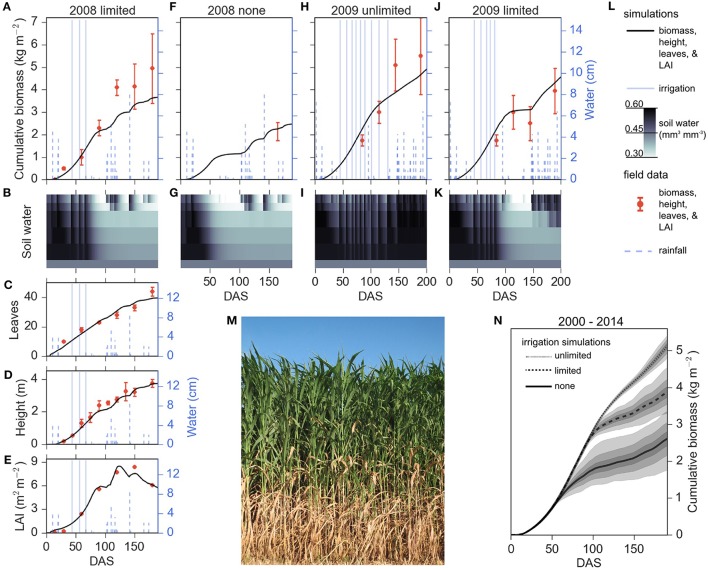
Growth simulations and field data of energy sorghum in unlimited, limited, and no irrigation regimes. Predicted biomass accumulation given 2009 and 2008 environmental conditions under unlimited (H), limited (A, J), and no (F) irrigation regimes fall within the margin of measurement error. Predicted leaf number (C), plant height (D), and leaf area index (LAI) (E) agree with experimental observations. Simulated water profiles from the three irrigation conditions are illustrated (B,G,I,K). The respective soil water layers 1–6 are illustrated where the layers are 0–150, 150–300, 300–600, 600–900, 900–1200, and 1200–1500 mm depth, respectively. Plotting descriptors are provided in panel (L), and experimental data are plotted showing means and error bars representing one standard deviation where available, and the minimum and maximum range of observations in F (Olson et al., 2012). (N) Average simulated biomass accumulation for the 2000–2014 cropping seasons for different irrigation regimes. The means of unlimited, limited, and no irrigation are plotted with continuous, dashed, and dotted lines, respectively. Each irrigation regime has 68, 98, and 100 percent confidence intervals depicted with decreasing shades of gray. The mean and confidence intervals were estimated with 50,000 bootstraps. (M) An image of energy sorghum hybrid, TX08001, in 2016 College Station, TX, cropping season 108 days after sowing.